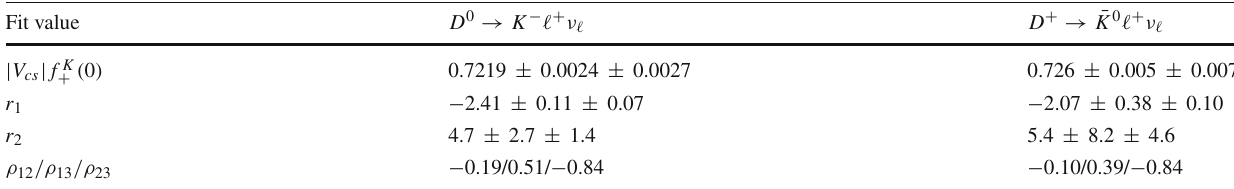
Table 276 Results for the D 0 → K − (cid:12) + ν (cid:12) and D + → ¯ K 0 (cid:12) + ν (cid:12) decays channels using the z -expansion formalism at second order Fit value